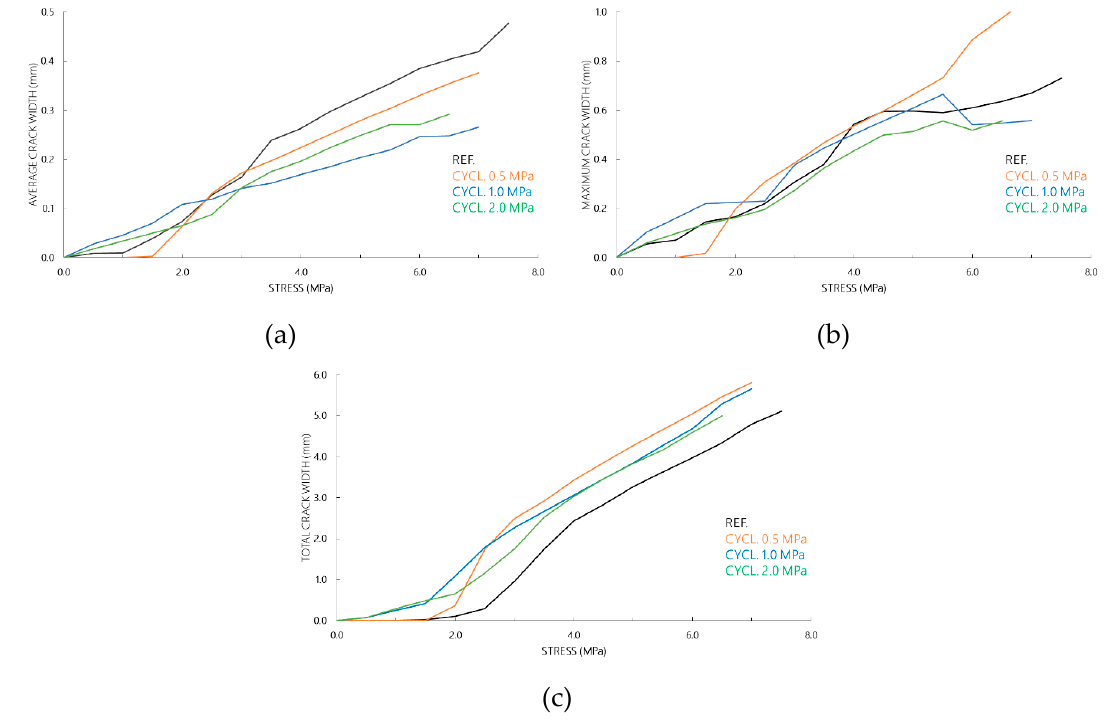
Figure 14. The cracking patterns of the different series were compared using the: ( a ) the average crack width, ( b ) the maximum crack width and ( c ) the total crack width.